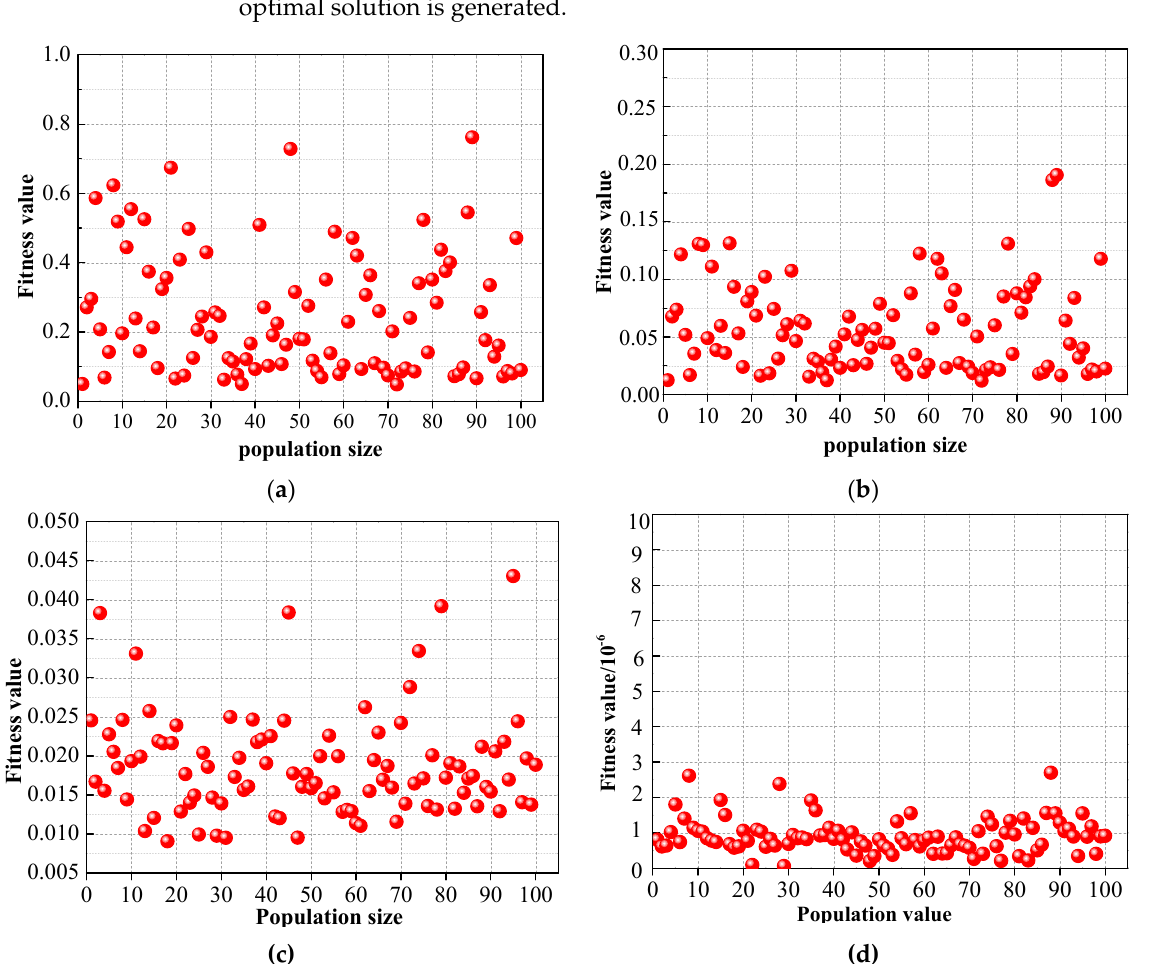
Figure 4. Fitness values with different evolutions. ( a ) 1st evolution. ( b ) 15th evolution. ( c ) 30th evolution. ( d ) 45th evolution.